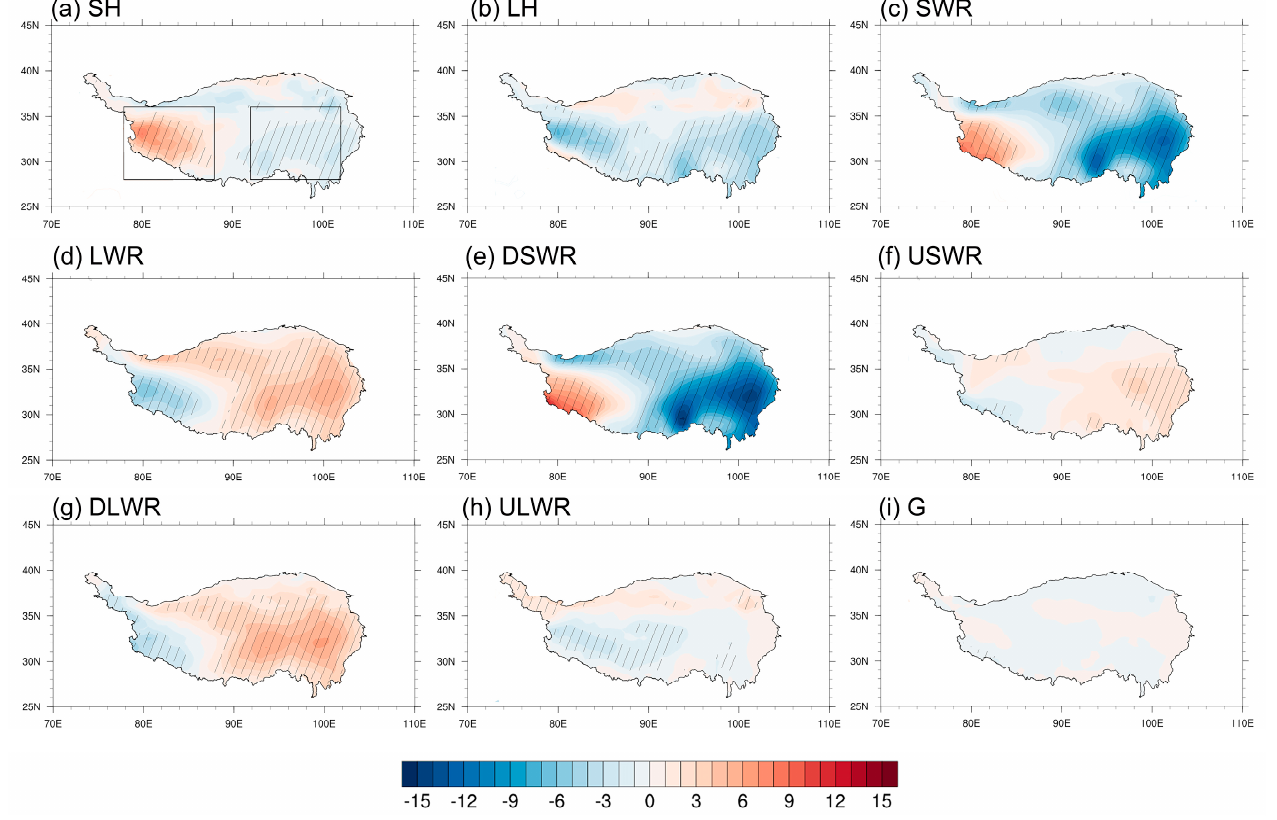
Figure 7. Anomalies in the interannual component of SH ( a ), LH ( b ), SWR ( c ), LWR ( d ), DSWR ( e ), LSWR ( f ), DLWR ( g ), ULWR ( h ), and G ( i ) regressed on PC2-IA (shading, W m − 2 ). Grid points with statistically significant anomalies passing the 95% confidence level are denoted by oblique lines. The two black rectangles denote the western TP (28–36 ◦ N, 78–88 ◦ E) and eastern TP (28–36 ◦ N, 92–102 ◦ E).